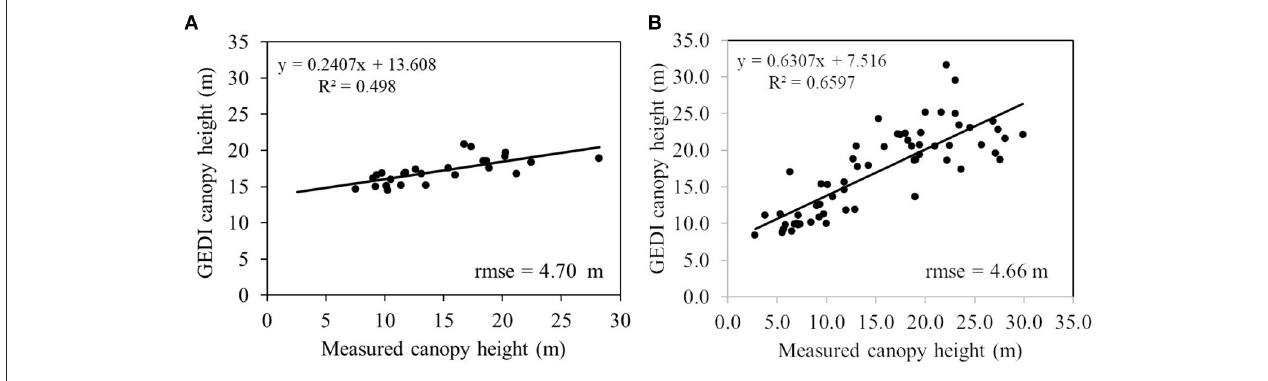
FIGURE 9 | (A) Showing the scatter plot for ground truth points in the non-GEDI footprint region (26 points) and (B) shows the validation plot for ground truth located in the vicinity of GEDI footprints (62 points).